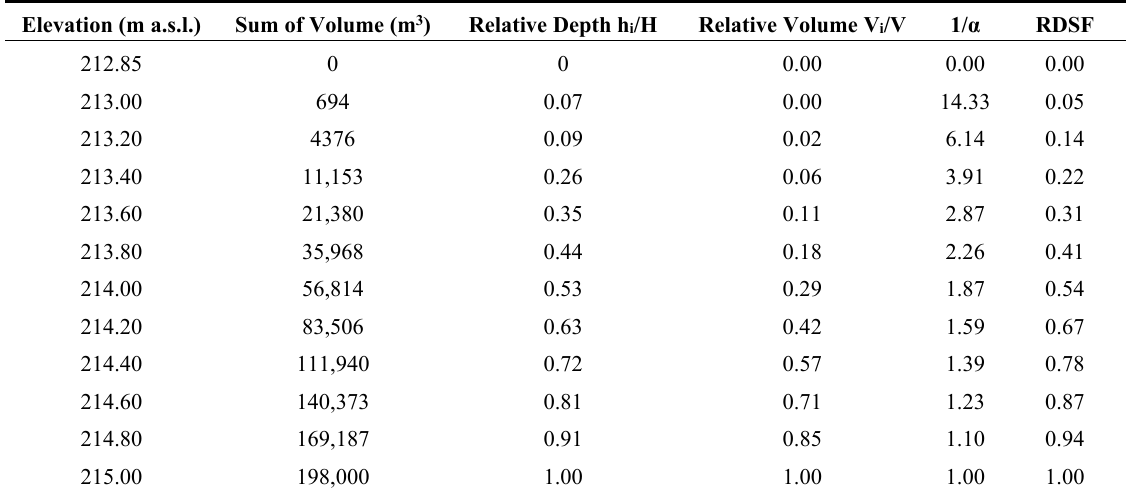
Table 6. Relative Depth Shape Function for different elevations from reservoir bed established for Zes ł awice-2 reservoir.